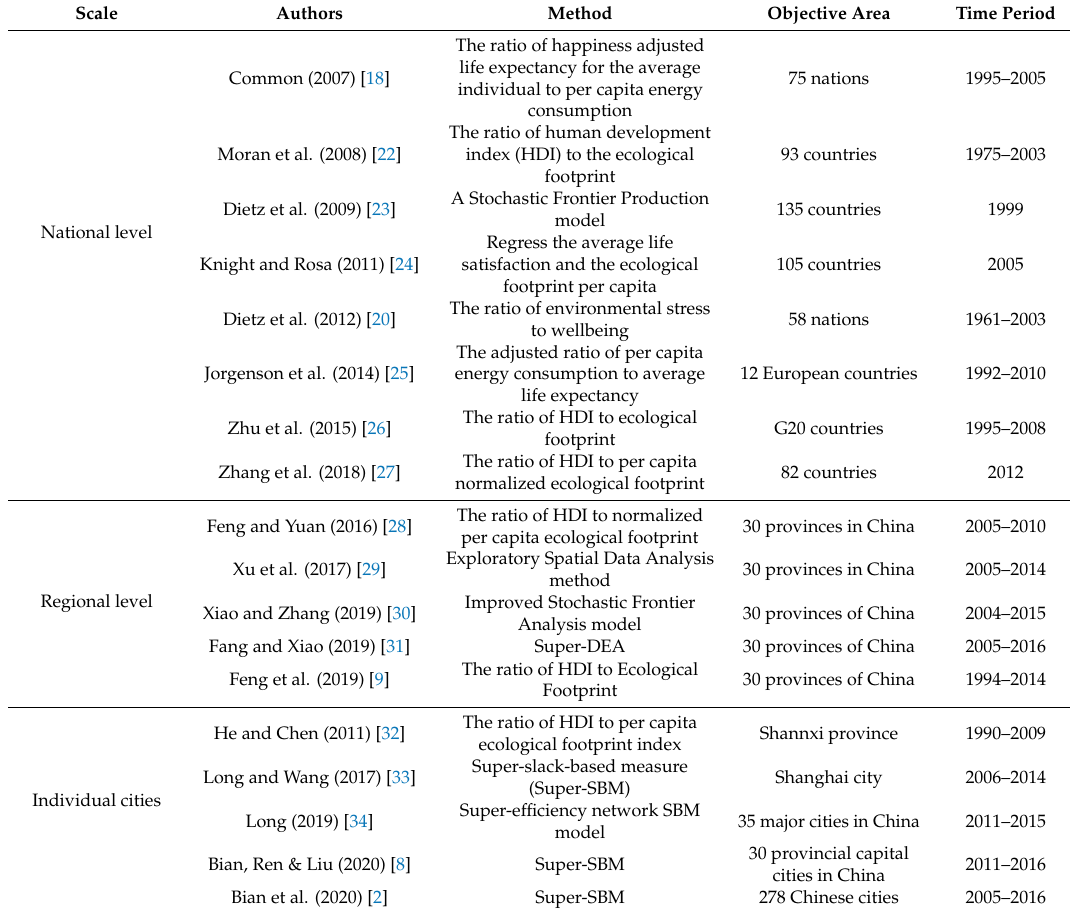
Table 1. Related ecological wellbeing performance (EWP) studies and the varying